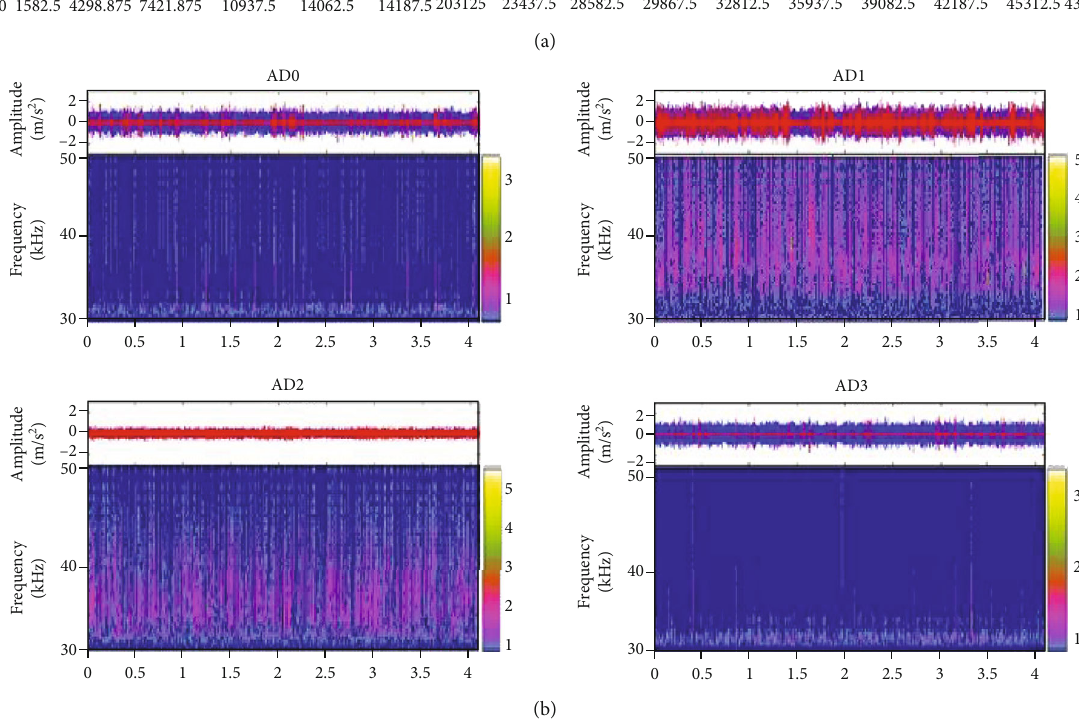
Figure 9: Analysis of the monitoring signal of sand production in the fi eld experiment: (a) frequency domain diagram; (b) time